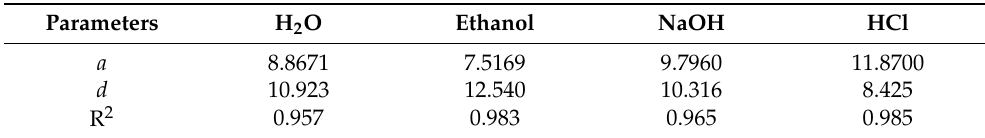
Table 1. Parameters of the exponential decay model for RB5 dye removal by original fique fibers with different protonation treatments. Parameters H 2 O